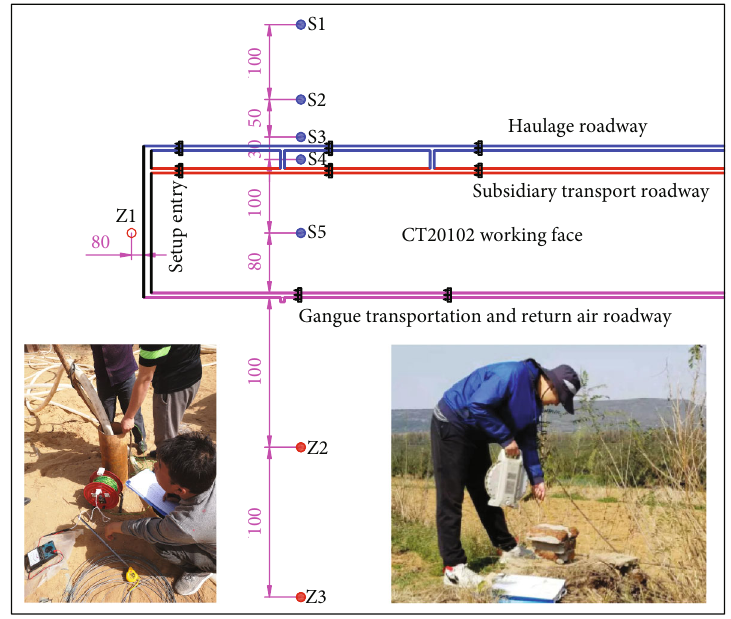
Figure 13: Layout of the hydrological monitoring system.